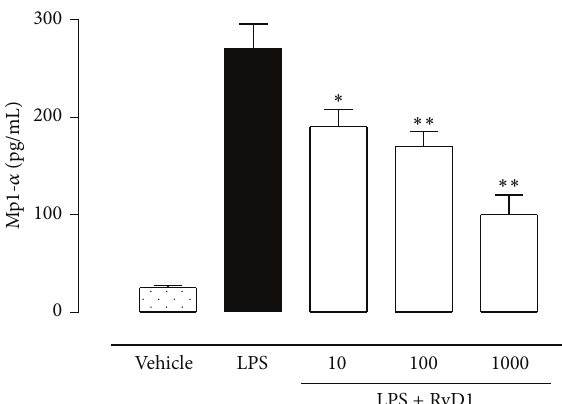
Figure 11: Intravitreal Resolvin D1 (RvD1) reduces the ocular content of MIP-1 𝛼 . The ELISA assay shows decreased chemokine MIP1- 𝛼 in the ocular tissues of LPS+RvD1 rats. Values are reported as mean ± SEM of 𝑛 = 6 observation for each group. ∗ 𝑃 < 0.05 and ∗∗ 𝑃 < 0.01 versus LPS-treated